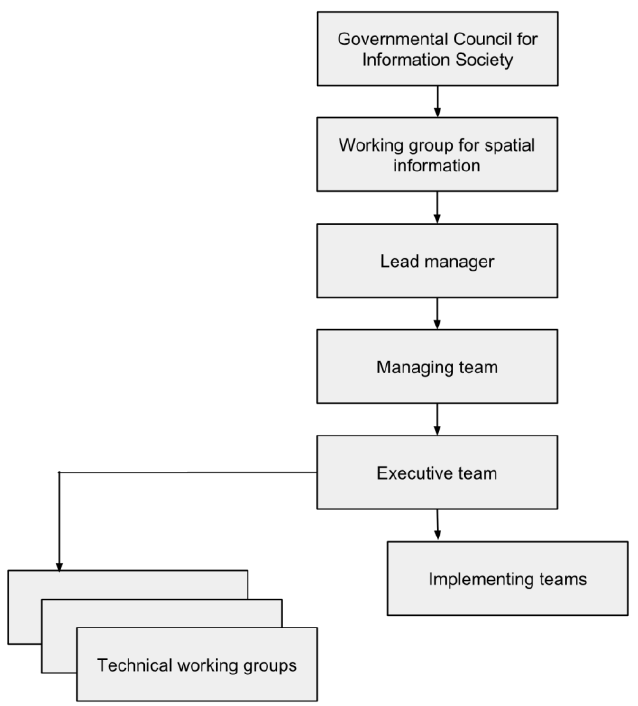
Figure 2. The organizational schema for the implementation of the GeoInfoStrategy Action Plan.